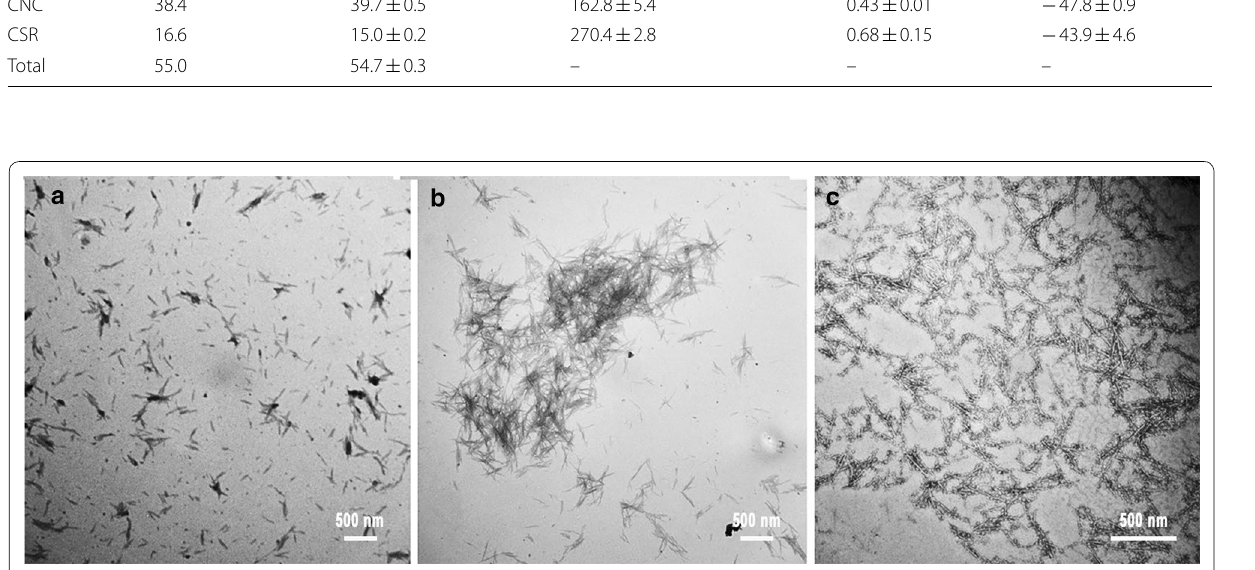
Fig. 4 TEM images of a CNC at optimal conditions, b CSR at optimal conditions, and c CNF (or microfluidized CSR) from high CSR yielding conditions (i.e., run 17–54% w/w acid, 45 °C, 90 min, 20 mesh)